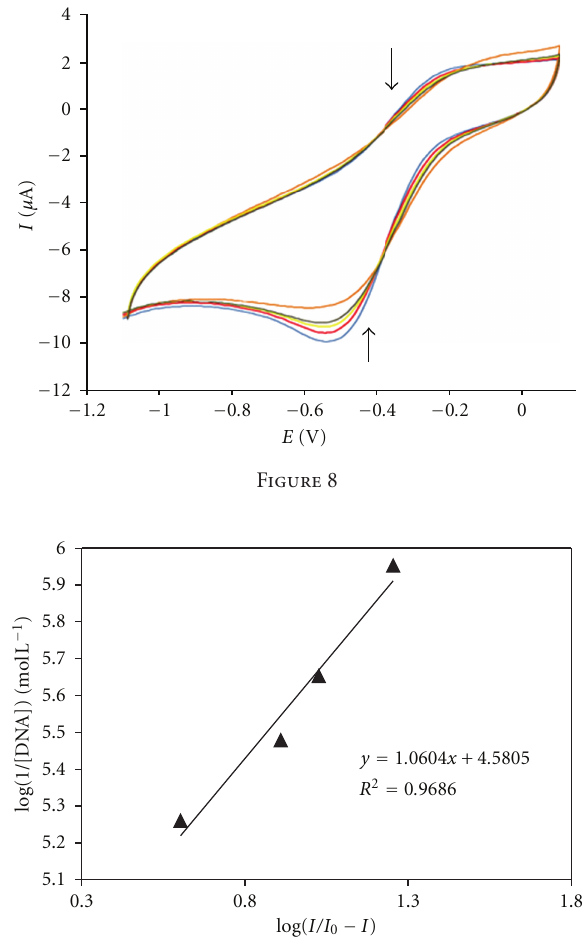
Figure 9: Cyclic voltammogram of 0.1mM Fe(III) complex on a polished glassy carbon electrode in the absence and presence of di ff erent concentrations of DNA. v: 100mVs − 1 , bu ff er: 0.05 M Tris- HCl bu ff er (pH